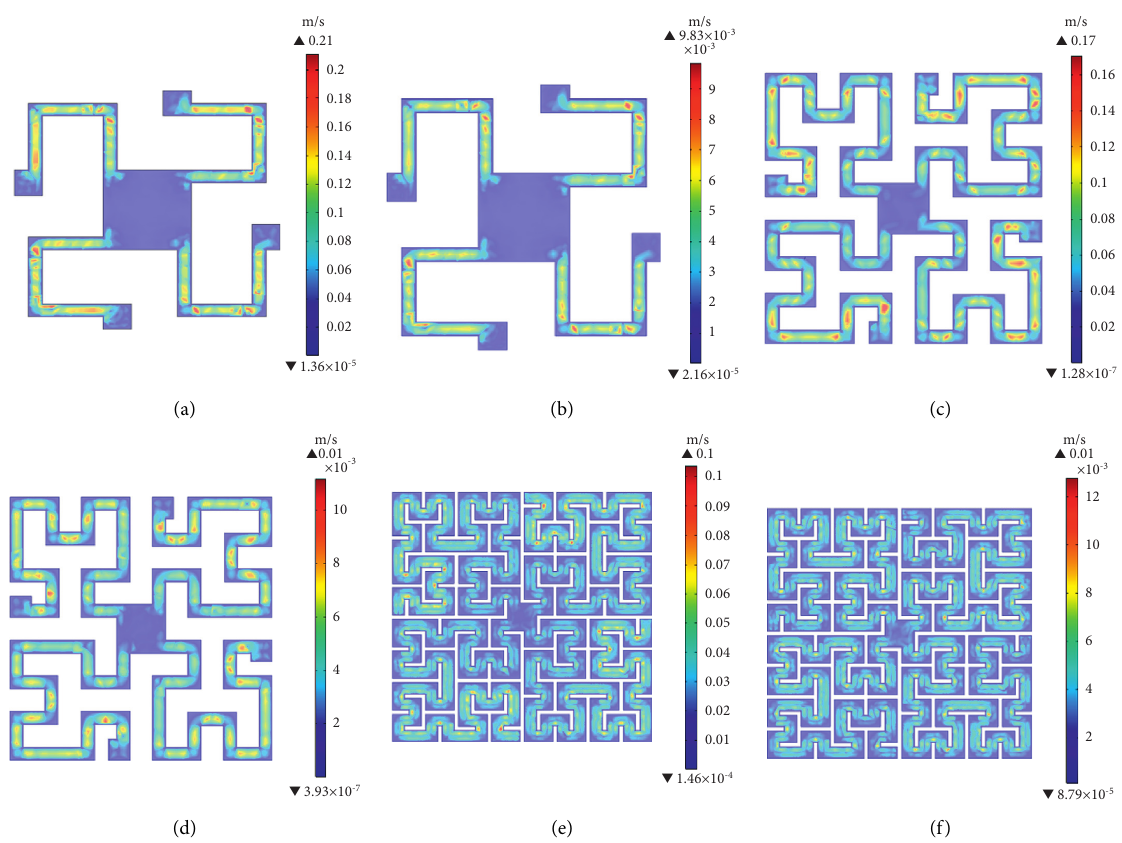
Figure 6: Particle velocity distributions of the metamaterial structures of each order. (a) 214Hz centre plane particle velocity distribution. (b) 400Hz centre plane particle velocity distribution. (c) 119 Hz centre plane particle velocity distribution. (d) 200Hz centre plane particle velocity distribution. (e) 69Hz centre plane particle velocity distribution. (f) 150Hz centre plane particle velocity